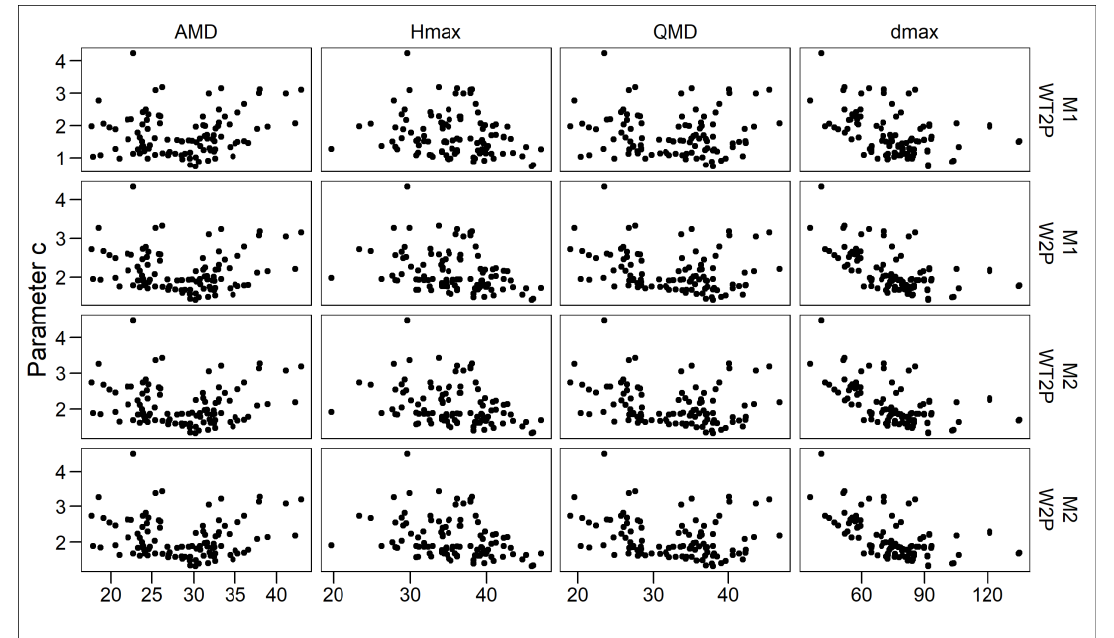
Figure 3. Parameter c variation in relation to stand characteristics. AMD, QMD, and dmax x-axis are in cm while Hmax x-axis is in m.